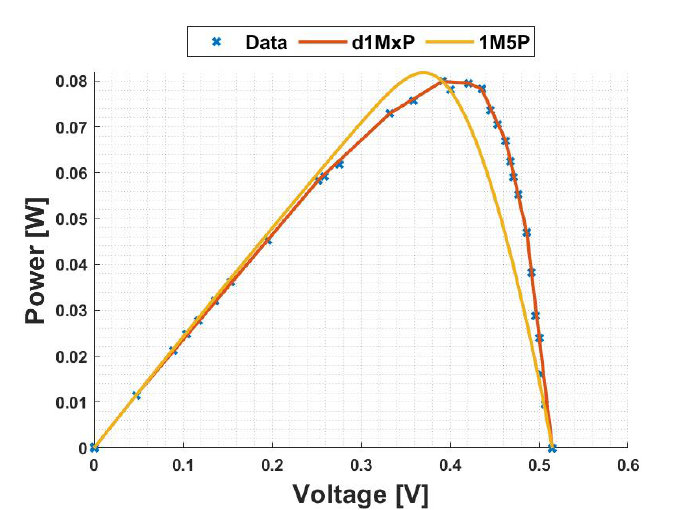
Figure 13. P-V curves using the 1M5P model and the proposed model, at T = 60 ◦